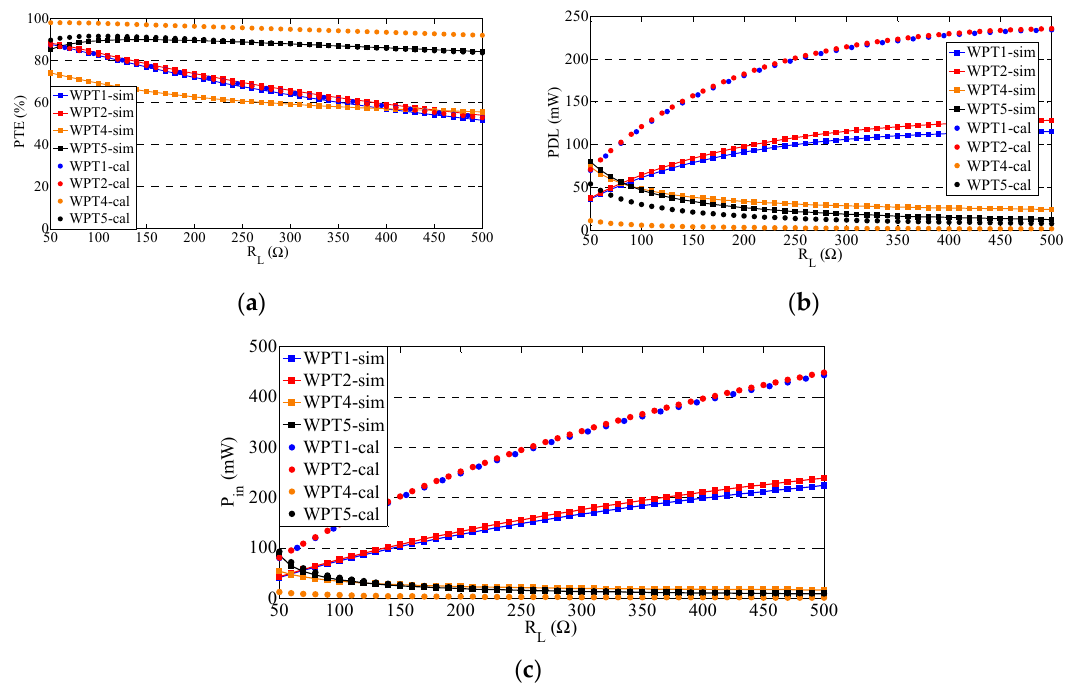
Figure 3. Effect of load resistance variations on the power transfer efficiency ( a ); on the power delivered to the load ( b ); and on the input power ( c ). The terms “-cal” and “-sim” refer to the calculation and simulation results, respectively.